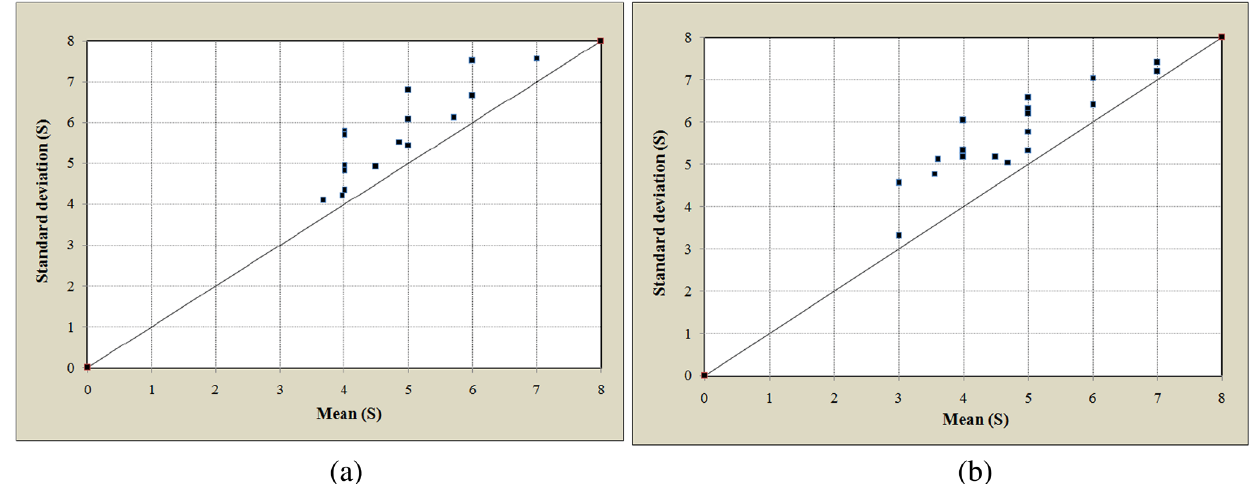
Fig. 3 Scatter diagram for standard deviation vs. mean of headways: a west bound and b East bound